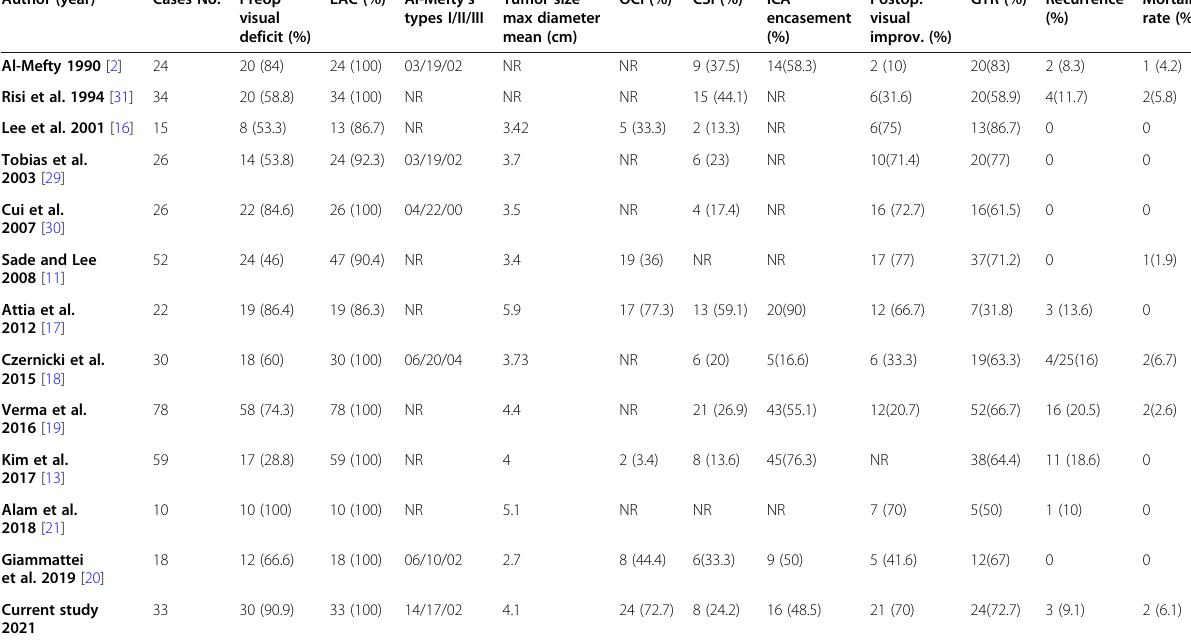
Table 4 Recent studies of outcome of patients surgically treated for ACMs using the EAC approach and tumor